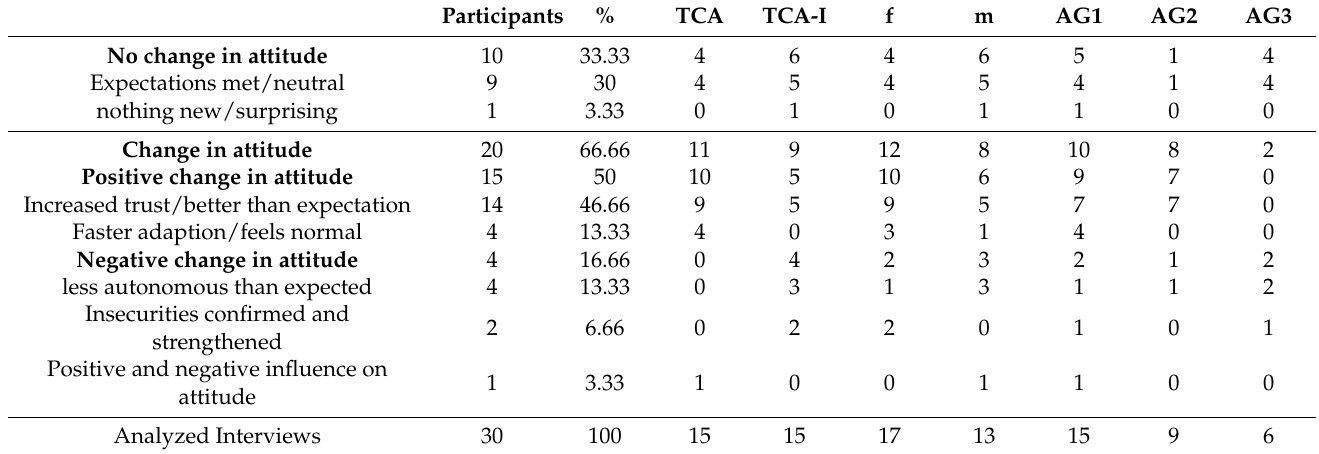
Table A5. Attitude towards the Automated Shuttle and AVs in General.